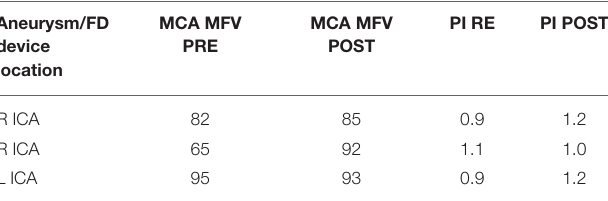
TABLE 3 | Comparison of TCD results pre- and post-FD treatment in three patients. Aneurysm/FD